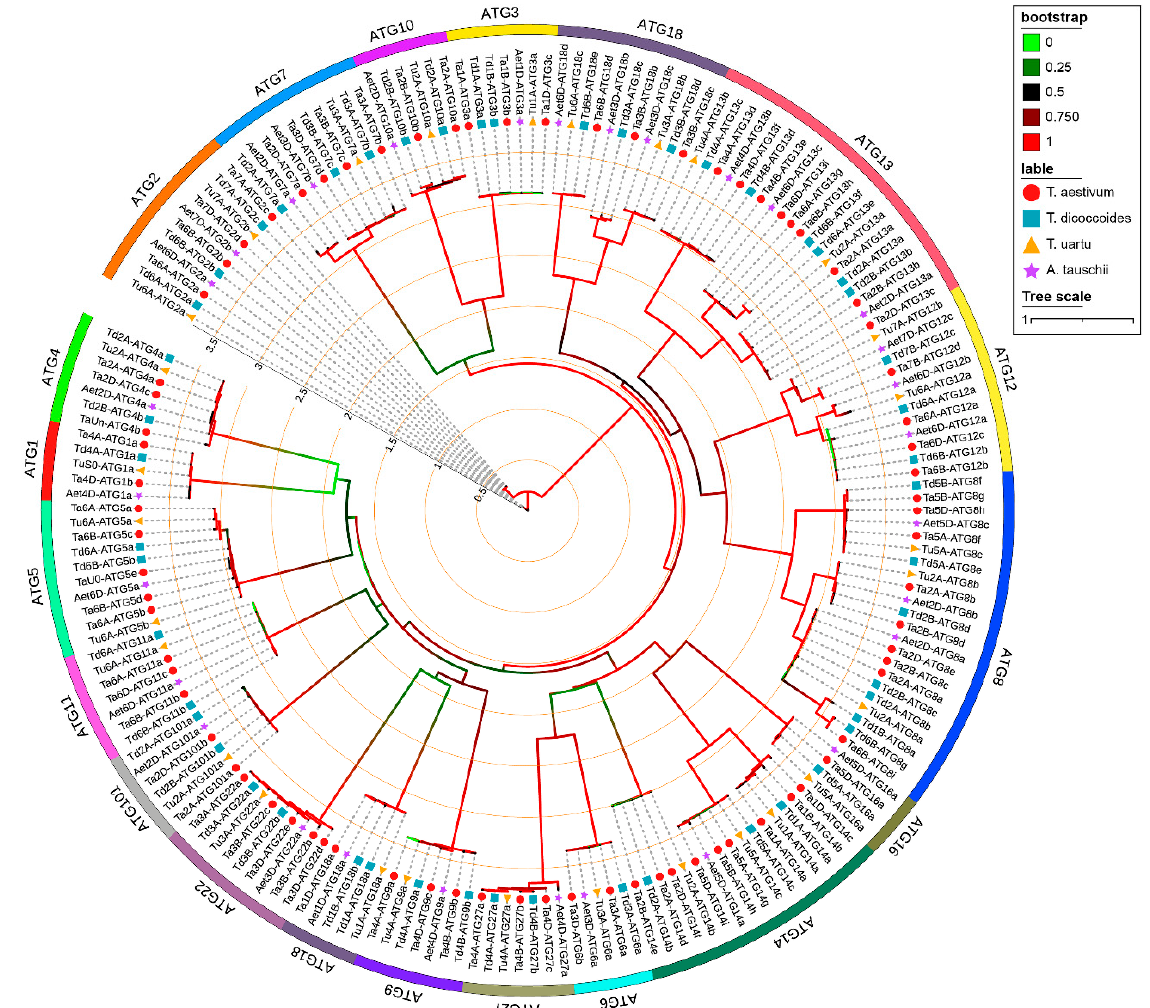
Figure 1. Maximum likelihood phylogeny of autophagy-related proteins (ATGs) from wheat ( T. aestivum ), wild emmer ( T. turgidum ssp. dicoccoides ), T. urartu and A. tauschii . IQ-TREE software was used to construct a phylogenetic tree of ATGs with the bootstrap value estimation based on 1000 iterations and visualized by iTOL. The names with a solid red circle are wheat ATGs, dark- turquoise square are wild emmer ATGs, yellow triangle are T. urartu ATGs and purple star are A. tauschii ATGs. The Green to red color represents the low to high bootstrap value. All identified ATGs were grouped into 19 clusters